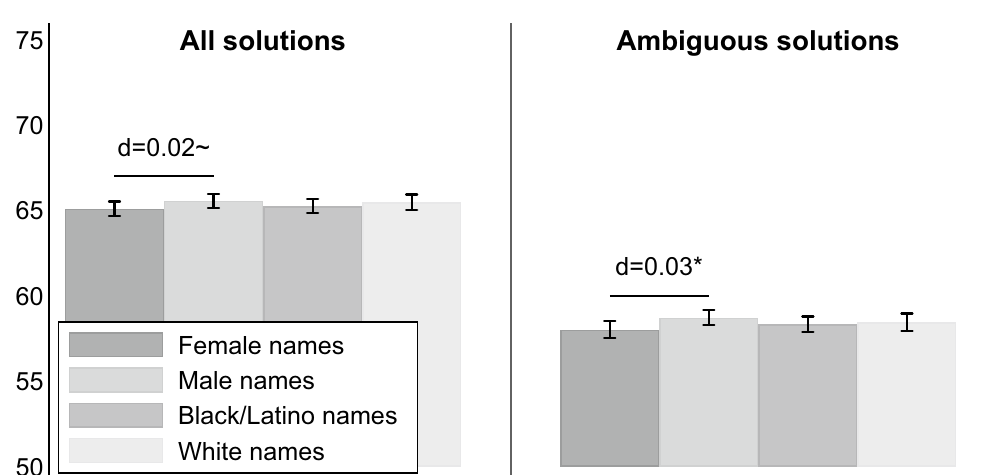
Fig. 4 Mean ability ratings for ambiguous student solutions by gender and race of student names. Heteroskedastic‑robust standard errors clustered on teachers appear as bars around the mean estimates. Models also include controls for correctness ratings, item, and item positioning on the